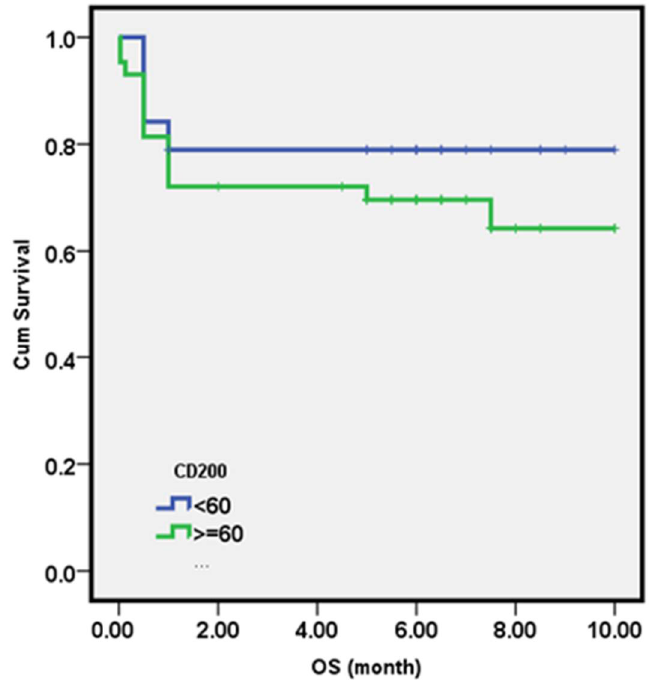
Figure 3. Overall survival probability of B-ALL patients with respect to CD200 expression.